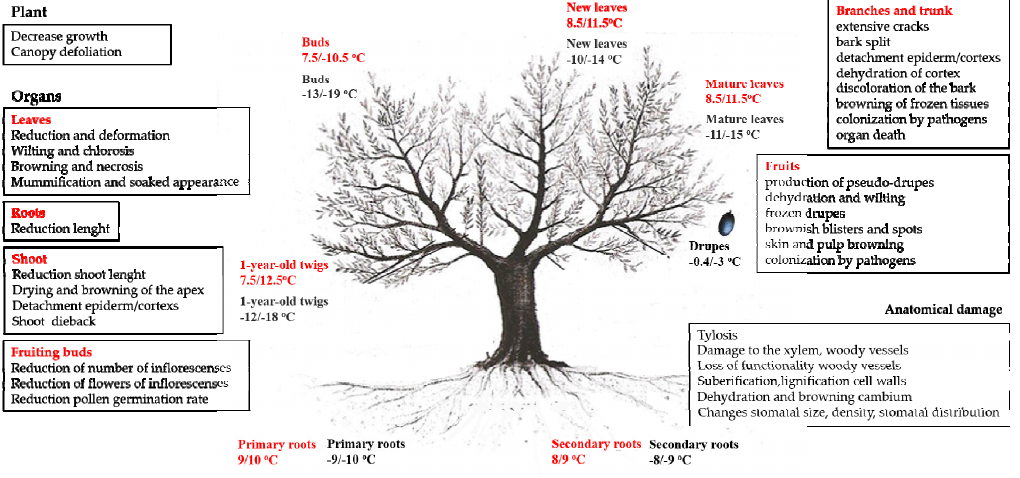
Figure 2. Critical (in red) and freezing (in black) temperatures in different organs of the olive tree [12,16]. In the box, major damage suffered by olive tree as a result of cold stress. Cold stress in plants is classified in “Chilling stress” and “Freezing stress”. Chilling